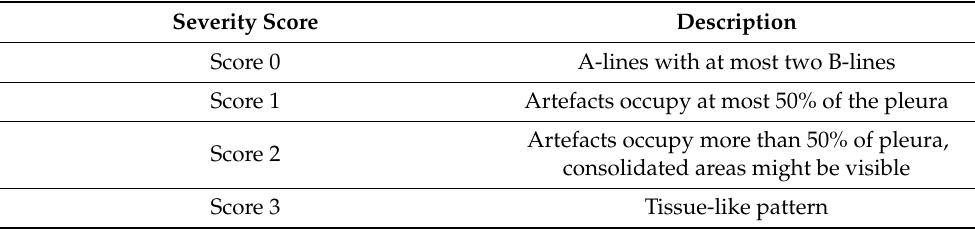
Table 1. The pneumonia severity scale